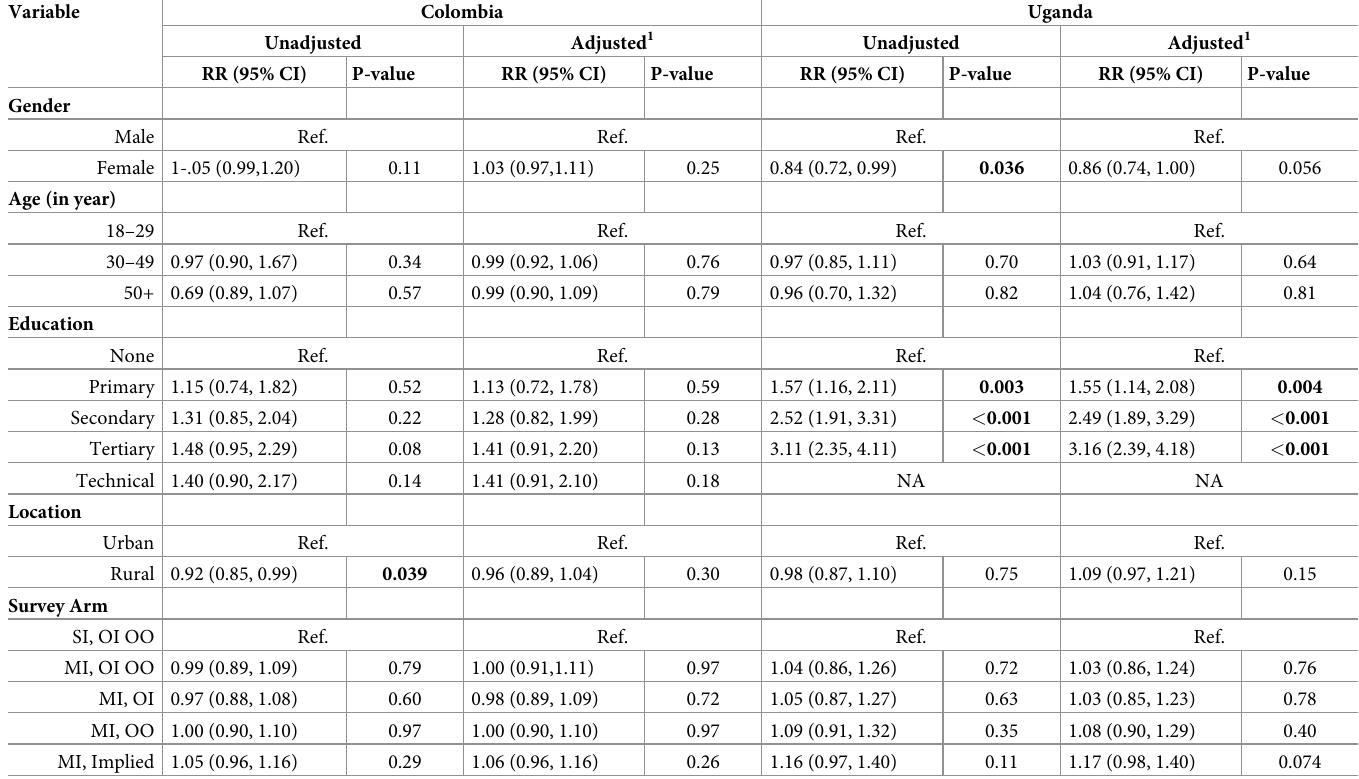
Table 5. Association of correct response with sociodemographic characteristics and study arms by